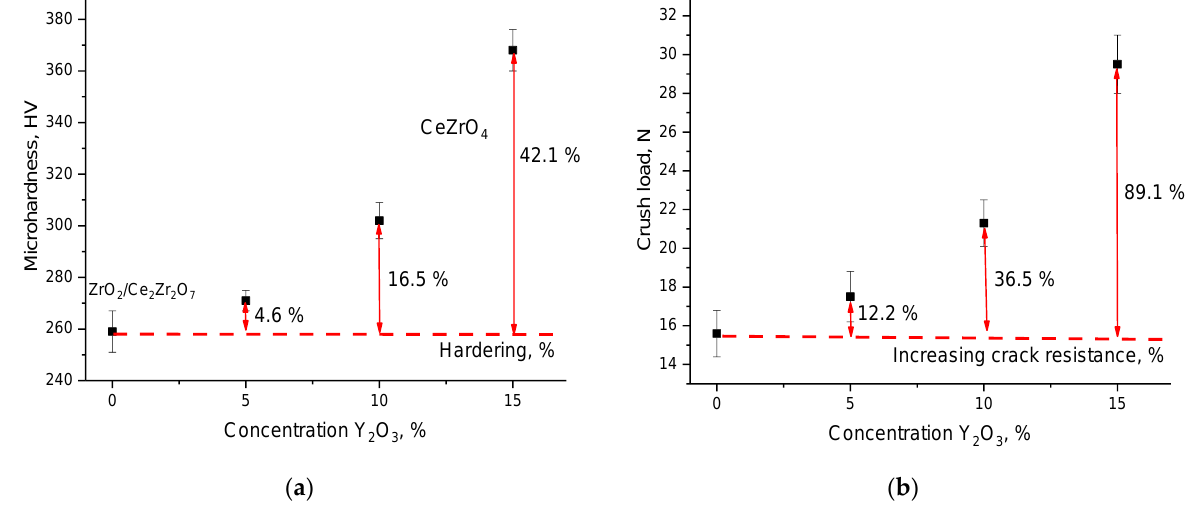
Figure 4. ( a ) Results of the microhardness value change depending on the dopant concentration. ( b ) Results of changes in the single compression resistance of ceramics depending on the dopant concentration.